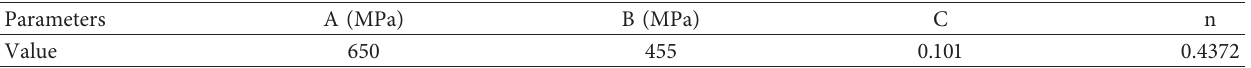
Table 2: Calculated Johnson–Cook model parameters for